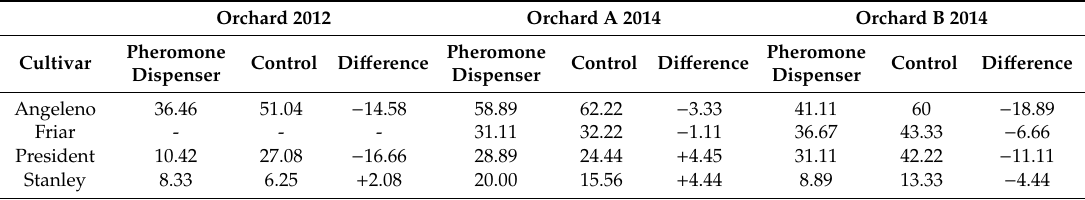
Table 3. Percentage of infestation recorded at harvest, and di ff erences between treated and control in the di ff erent cultivars and